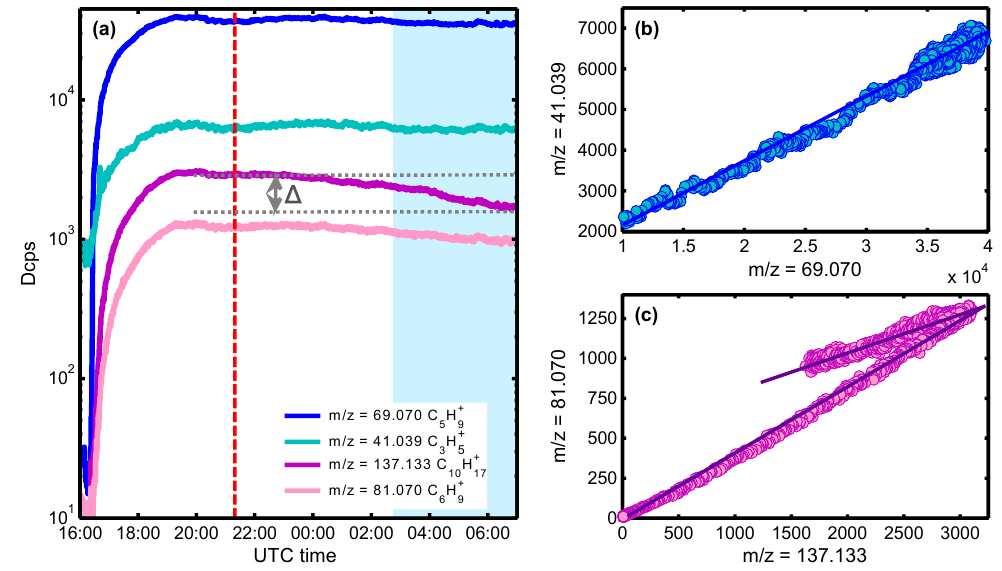
Figure 1. (a) Time series of isoprene observed at the protonated mass m/z = 69.070, its main fragment at m/z = 41.039, sum of isoprene cluster and monoterpenes ( m/z = 137.133) and their main fragment ( m/z = 81.070) during the 2016 experiment. The blue shaded area corresponds to times with the cryotrap switched on; the dashed red line indicates the start of O 3 ; (cid:49) marks the signal loss caused by ozonolysis and cryotrap freeze-out. (b) Correlation plot of m/z = 69.070 and its main fragment m/z = 41.039; (c) correlation plot of m/z = 137.133 and its main fragment m/z = 81 .